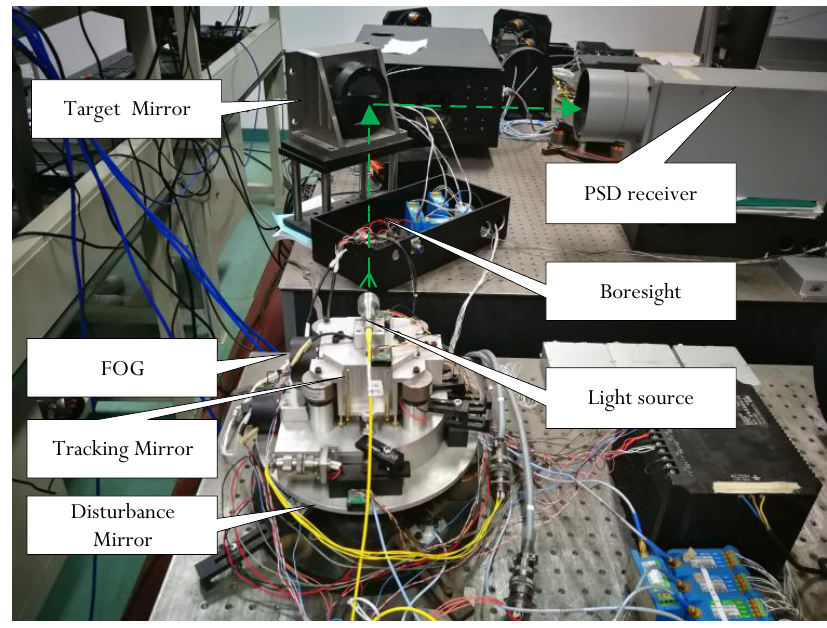
Figure 9. Experimental setup.